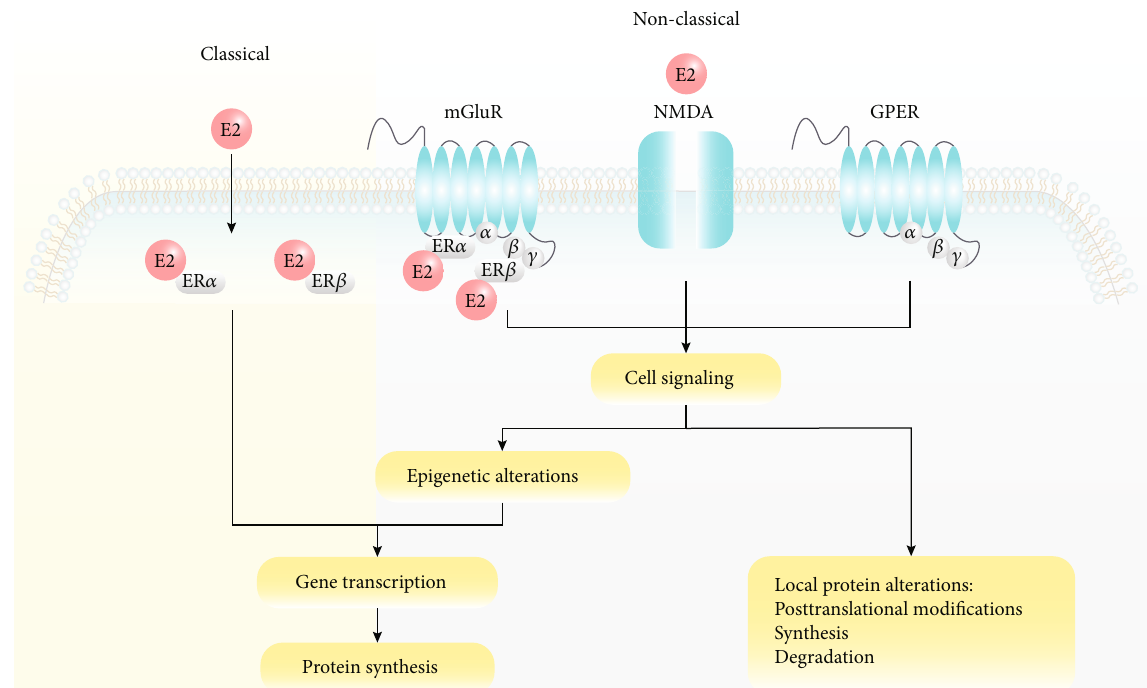
Figure 3: Genomic and nongenomic mechanisms underlying the regulatory e ff ects of estrogen on neurogenesis. Classical receptors, ER α and ER β , are located in the cytoplasm or nucleus and induce genomic e ff ects when combined with estradiol. Membrane-associated receptors, GPER, mGluR, and NMDA, are localized in the plasma membrane of neurons (e.g., tether proteins on cell membranes) and trigger rapid nongenomic e ff ects primarily through kinase activation. Abbreviations: E2: estradiol; ER: estrogen receptor; mGluR: metabotropic glutamate receptor; NMDA: N-methyl-D-aspartate; GPER: G protein-coupled estrogen